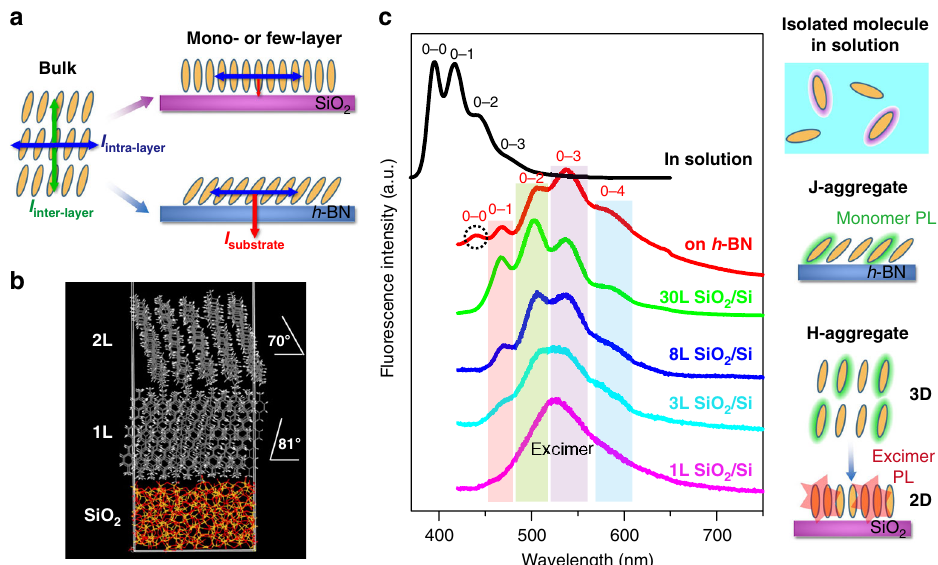
Fig. 5 Crystalline structure and optical properties. a Schematic illustration of 2D crystals on different substrates (SiO 2 or h -BN). Unlike their bulk counterparts, molecular packing in the fi rst few molecular layers is governed by the competition between the intra-layer interaction ( I intra-layer ) and molecule – substrate interaction ( I substrate ). On h -BN, strong I substrate leads to a tilted con fi guration; while on SiO 2 , weak I substrate leads to an approximately freestanding con fi guration. b The optimized model of p-MSB molecular layers on amorphous SiO 2 . c PL spectra of p-MSB in solution, p-MSB crystals on h - BN, and SiO 2 /Si. The right insets are schematic diagrams for the fl uorescence mechanism. Excimer-like emission is obtained when the p-MSB molecules are tightly packed in a 2D crystal on SiO